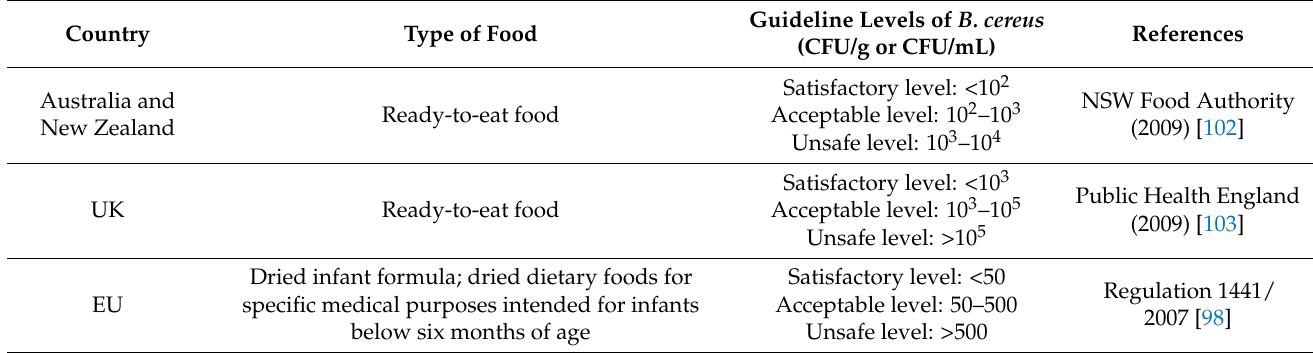
Table 2. Guideline levels of B. cereus in different